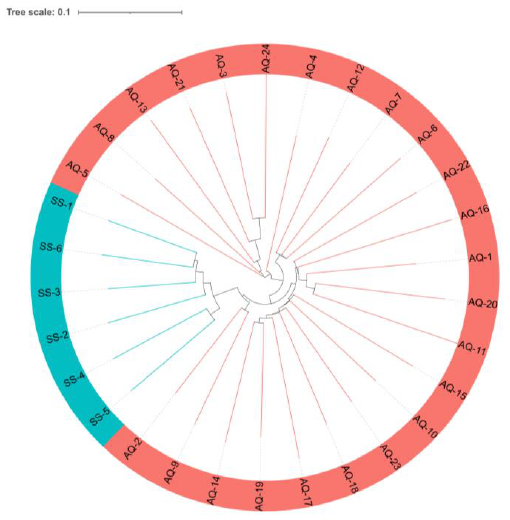
Figure 2. Principal component analysis (PCA) for the two main components of 30 individuals in two populations; pink nodes and light blue nodes represent the AQ and SS groups, respectively.